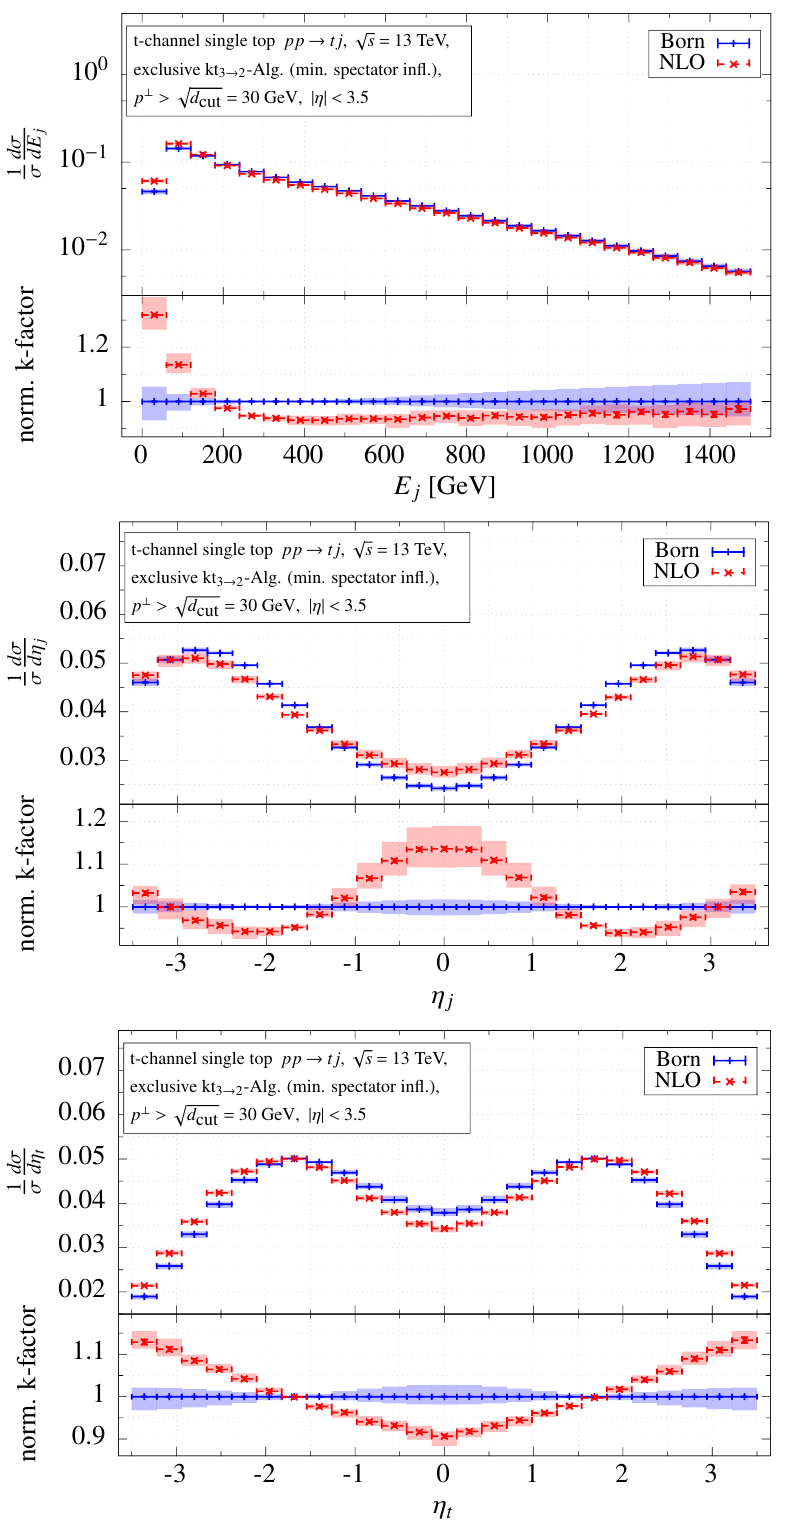
Figure 10 . Same as (cid:12)gure 9 but for the t -channel.